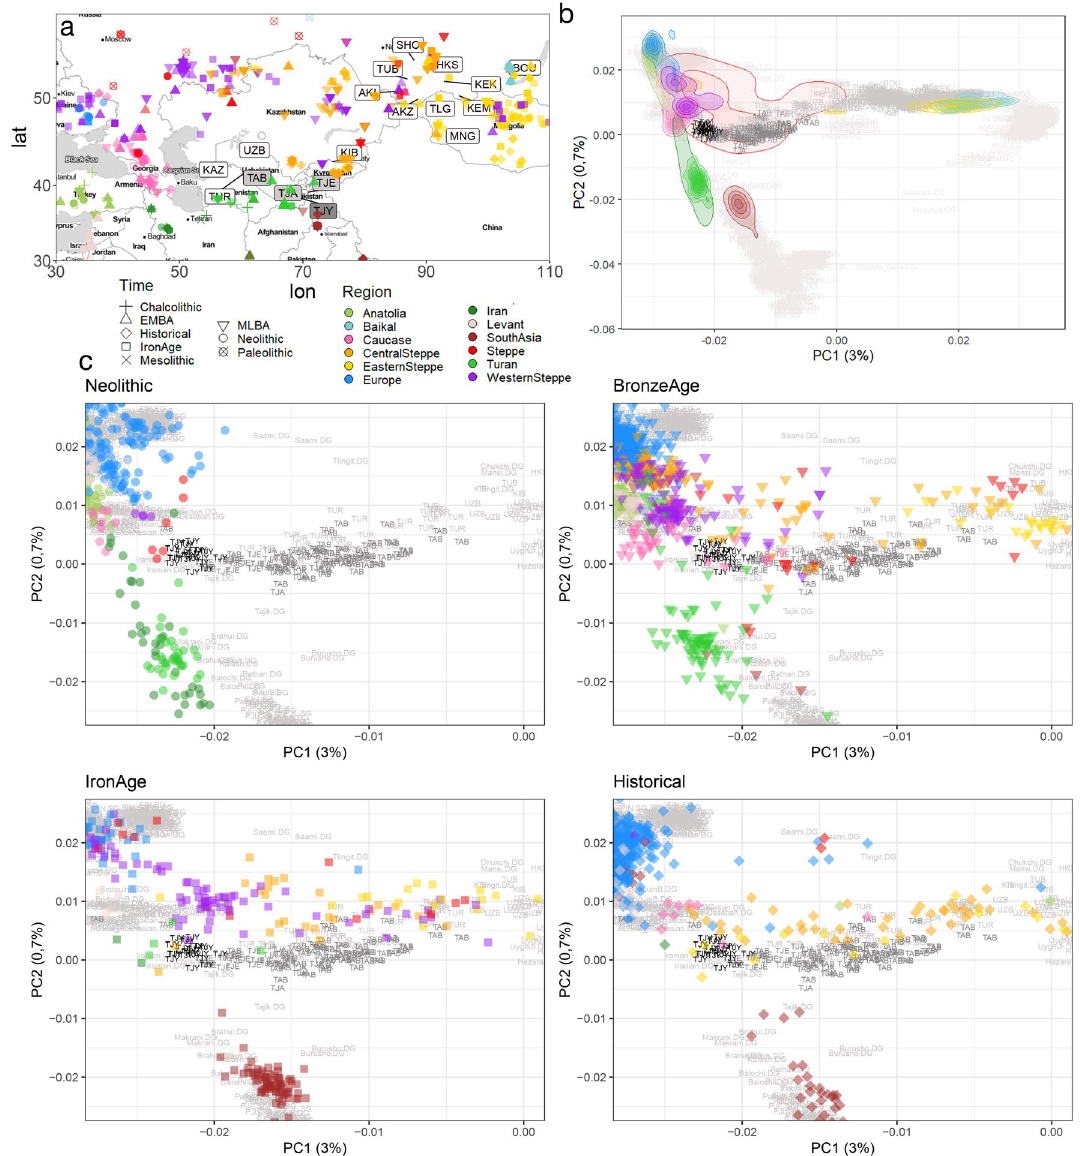
Figure 1. Geographic and genetic structure of our dataset. ( a ) Map of the published ancient samples in our dataset (Map generated using ggmap 46 and Map tiles by Stamen Design, under CC BY 3.0. Data by OpenStreetMap, under ODbL). ( b ) PCA computed on a set of 236,566 SNPs for present-day Eurasians populations including 527 present-day Central Asian individuals genotyped on an 300k SNPs array 15 and we projected the 3102 ancient genomes onto the two first Principal Components. Ancient genomes are represented with different colors by region, with density line to facilitate the reading. ( c ) Details of panel ( b ) focusing on Indo-Iranians individuals with ancient individuals from Neolithic, Bronze Age, Iron Age and Historical times. (Figures done with ggplot2 v. 3.3.3 R package https:// cran.r- proje ct. org/ web/ packa ges/ ggplo t2/ index. populations from Central Asia (mean value 10%), and around 8% of the component maximized in present-day South Asian populations (orange), which are both absent in Yaghnobis. The ADMIXTURE analysis is also congruent with the PCA concerning the ancient groups (see Supplemen- tary fig. S4 and S5). Indeed, Iron Age southern Central Asian individuals present a remarkably similar profile to Yaghnobis’ profile: for instance, the individual labelled as Turkmenistan_IA has a profile with about 25% of WSHG/EEHG component, 30% of Iran_N component and 35% of the Anatolian farmer ancestry component but missing BHG ancestry (Fig. 2). Bronze Age Central Steppe pastoralists show a similar profile except for a significant increase in Iranian ancestry, and Western Steppe pastoralists have the beige component maximized in Western European Hunter-Gatherers (WEHG), which is absent in modern Indo-Iranian populations.